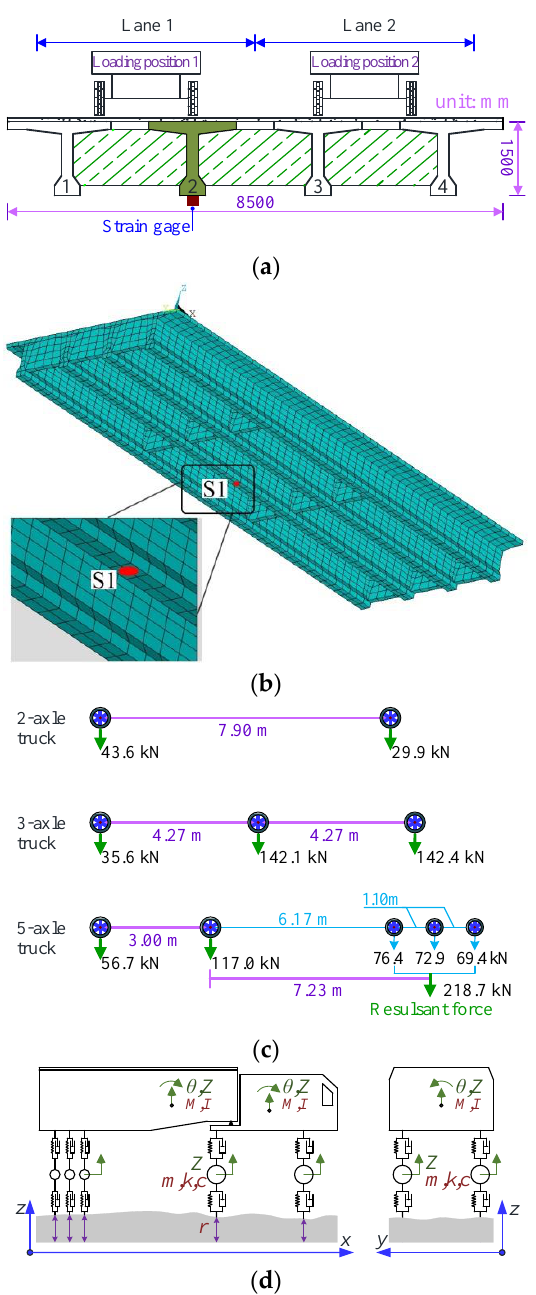
Figure 5. ( a ) Bridge section and loading position. ( b ) Finite element model of the bridge. ( c ) Configuration of the three trucks. ( d ) Analytic model of the 5-axle truck.